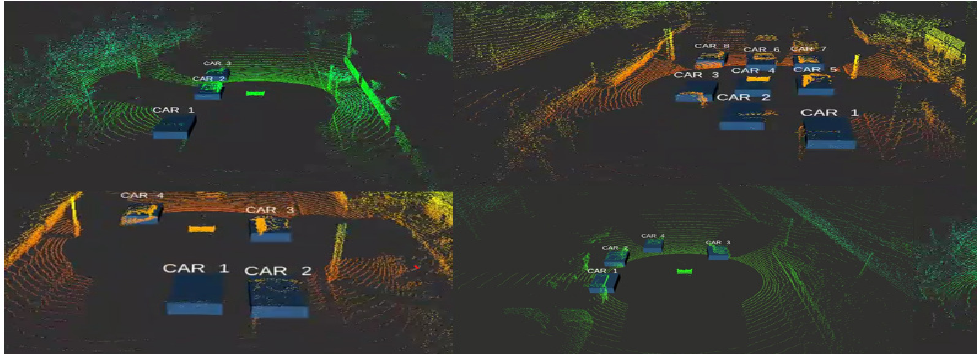
Figure 10. Qualitative results of the proposed model using the Ouster LiDAR-64 dataset in LiDAR frame.